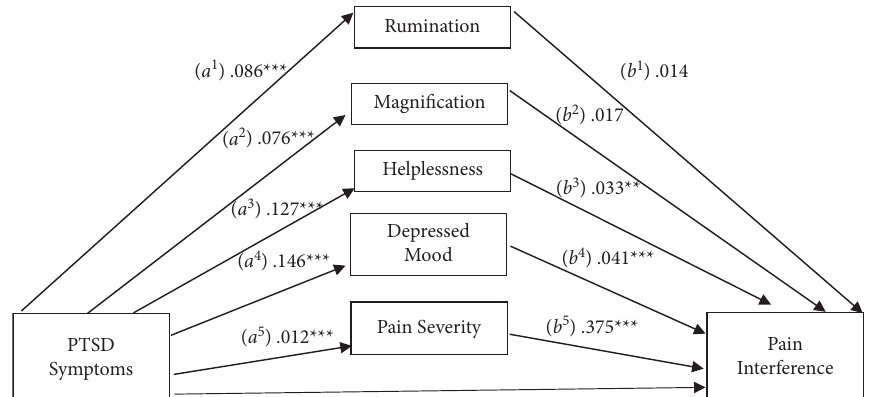
Figure 2: Mediation of the relationship between PTSD symptomatology and pain interference by pain catastrophizing subscales, depressed mood, and pain severity.